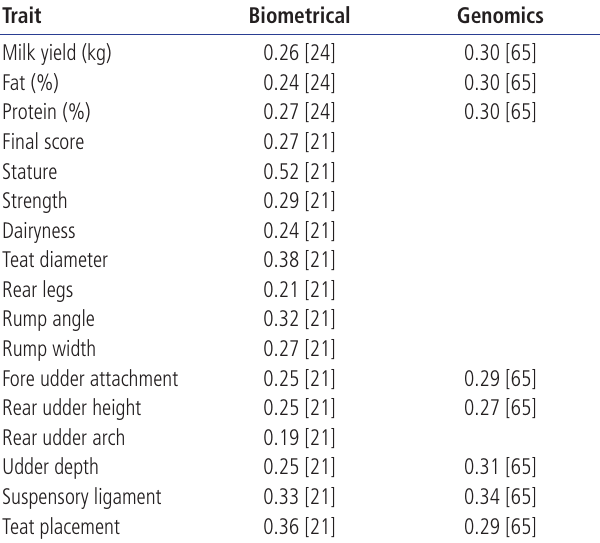
Table 1. Heritability estimates for production and type traits using a biometrical or genomics approach [citation follows the